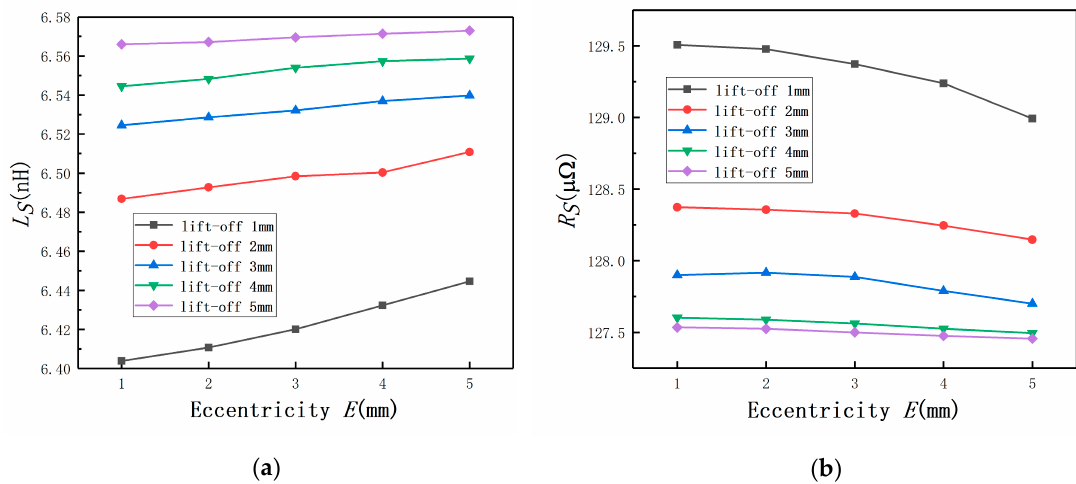
Figure 9. The change laws of the coil equivalent impedance under different lift-off: ( a ) coil equivalent inductance; ( b ) coil equivalent resistance.